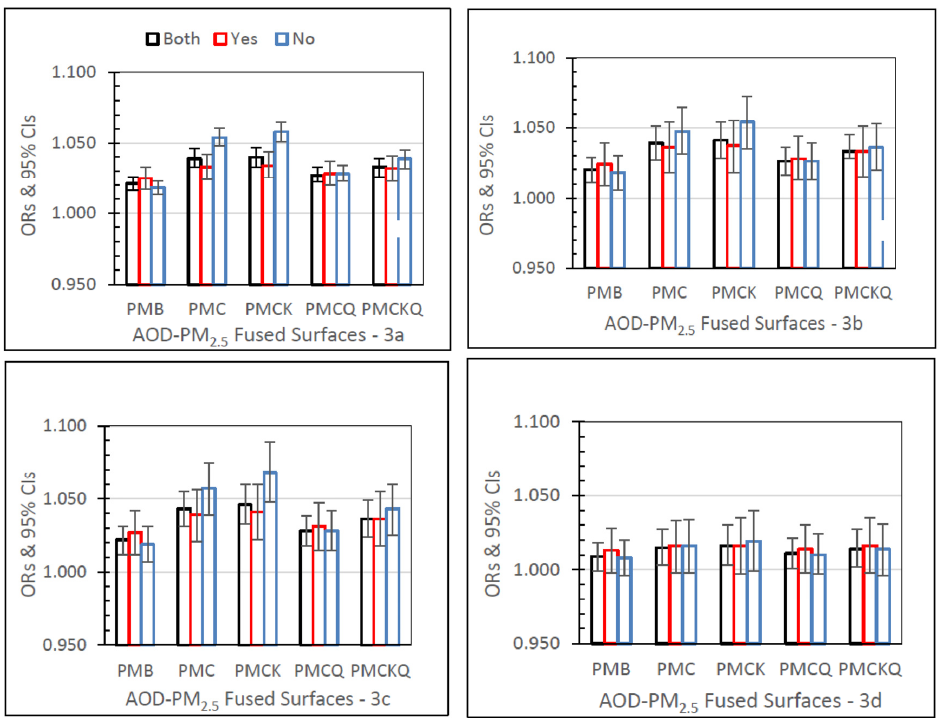
Figure 3. IP asthma ORs (95% CIs) for the four AOD-PM 2.5 and baseline PMB fused surfaces, in all grids (Both), and in grids with (Yes) and without (No) air monitors, and in separate panels for lag grids 0 ( a ), 1 ( b ), 01 ( c ), and 04 ( d ). 3.2.3. Inpatient Myocardial Infarction (IP MI) IP MI ORs for the four AOD–PM 2.5 and baseline PMB fused surfaces, for lag grids 0, 1, 01, and 04, are displayed in Figure 4. In the Both monitor grid condition, for lag grids 0, 1, and 01, the PMC, PMCK, and PMCKQ ORs were significantly higher than PMB ORs (all p’s ≤ 0.05). For lag grids 0, 1, and 01, the no monitor PMC and PMCK ORs were signif- icantly higher than the monitor PMC and PMCK ORs (all p’s ≤ 0.05).